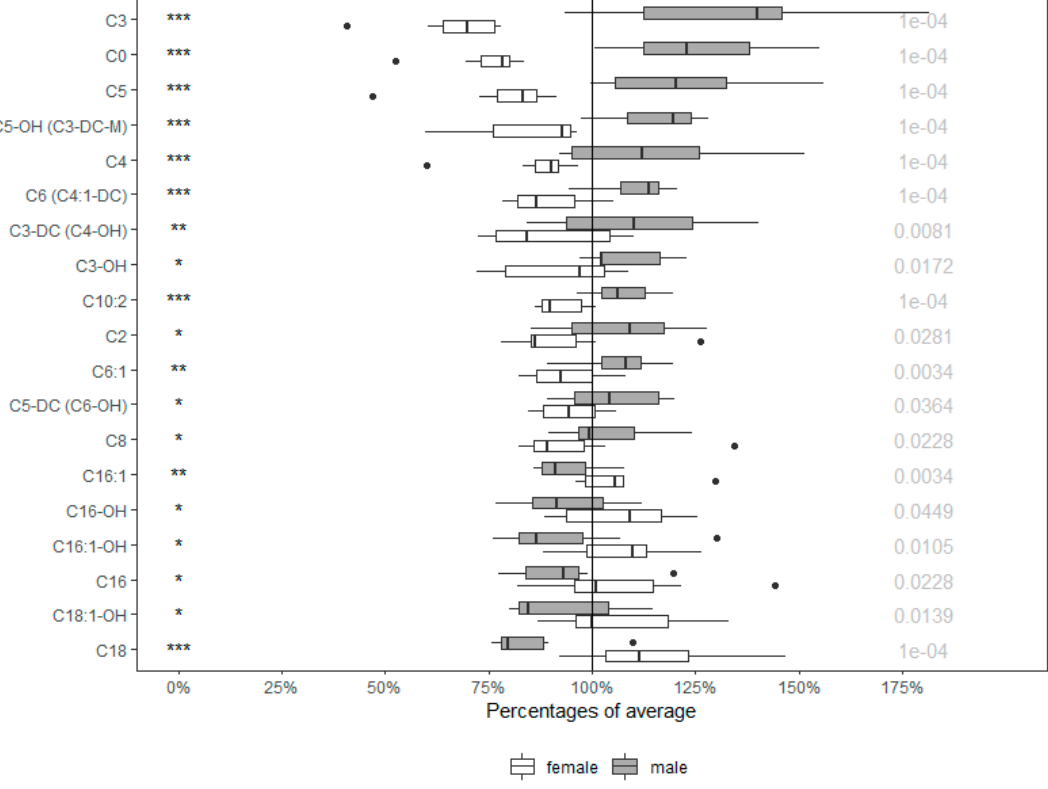
Figure 3. Percentages of average in acylcarnitines of males and females. Values in boxplots are expressed as ratio of each value in respect to the average. Significance is given by * p < 0.05, ** p < 0.01, and *** p < 0.001, respectively, with concrete p value at the end of the line. Orn (Ornithine), Tyr (Tyrosine), Met-So (Methionine-Sulfoxide), Gly (Glycine), Pro (Proline), t4-OH-Pro ( trans -4-hydroxyproline), Asp (Aspartate), Phe (Phenylalanine), Met (Methionine), Val (Valine), Gln (Glutamine), SDMA (Symmetric dimethylarginine), Trp (Tryptophan).